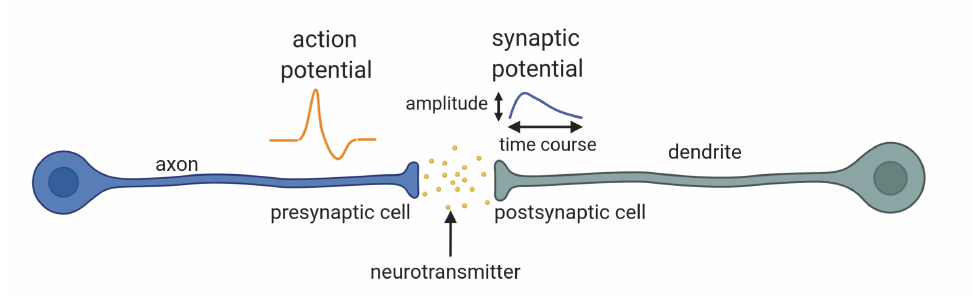
Figure 4. Schematic representation of metabolic costs. We show two main costs: action potentials and synaptic potentials. The action potential propagates along the axon. When the action potential arrives at the presynaptic cell or terminal, it delivers neurotransmitter that is received for the postsynaptic. The neurotransmitters activate receptors that allow the influx of ions and promote the depolarization (activation) of the postsynaptic cell. Depending on the quantity of neurotransmitters and the number of postsynaptic receptors, the postsynaptic cell can depolarize and generate the electrical signals called synaptic potentials. The synaptic potential cost depends on their time-course τ , amplitude w , and the number of outgoing links k out (presynaptic terminals). Adapted from